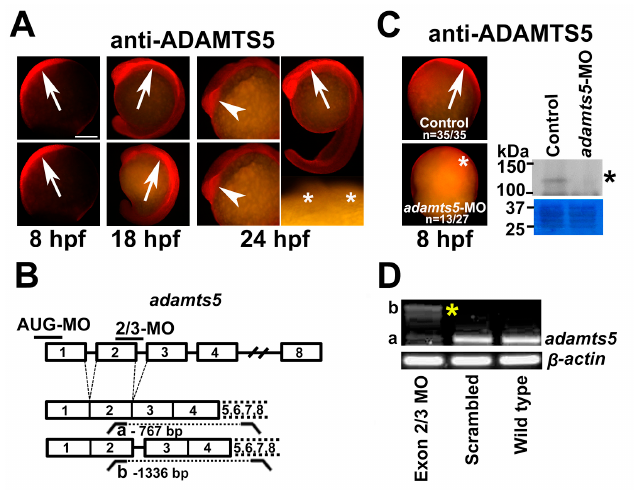
Figure 1. Expression and silencing of adamts5 in zebrafish embryos. ( A ) ADAMTS5 expression in 8, 18 and 24 hpf wild-type embryos. Note strong early expression in the dorsal mesoendoderm (8 hpf, arrows) and variable expression ventrally (8 hpf, arrowhead), with later expression in the floor plate of the neural tube (18 and 24 hpf, arrows) and bilaterally in the prosencephalon (24 hpf, arrowheads). Asterisks = prosencephalon in no primary antibody control. Scale bar = 250 μ m; ( B ) Schematic representation of the adamts5 gene structure targeted with antisense morpholino oligonucleotides (MO), and its subsequent splicing, indicating the primers used for RT-PCR and the size of the resultant products; ( C ) Reduced ADAMTS5 expression is seen in adamts5 AUG-MO injected embryos (asterisk) versus control (arrow) by whole-mount antibody labelling (left-hand panel) and Western blot (right-hand panel) showing the 120 kDa ADAMTS5 species (asterisk) with a region of the Coomassie blue stained gel shown below, demonstrating even loading; ( D ) RT-PCR of adamts5 mRNA obtained from 24 hpf embryos following injection of the adamts5 2/3-MO at the 1-cell stage, showing amplicons a and b (asterisk). β -actin was used as a house-keeping gene.